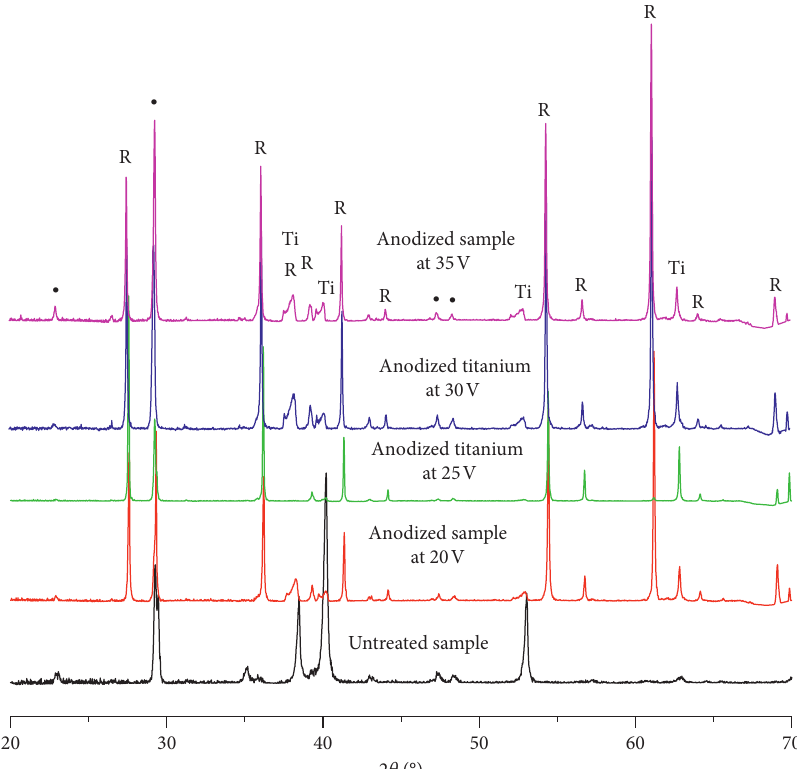
Figure 8: X-ray diffraction of anodized samples annealed at 800 ° C for 5 Hours. • : Simple careers; Ti : titanium; R: rutile.